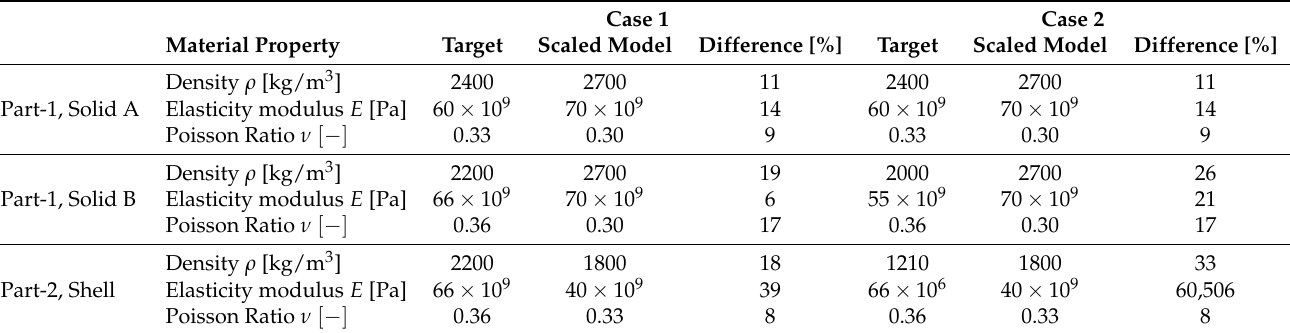
Table 1. Comparison between the material properties of the target and scaled models for Cases 1 and 2.